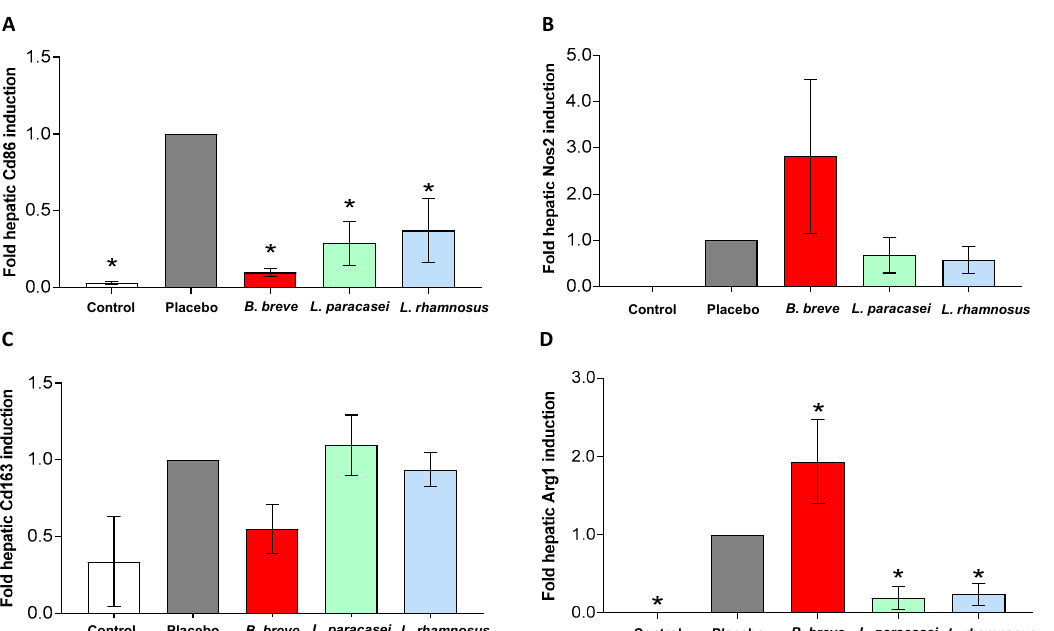
Figure 7. Expression of macrophage genes in liver. M1 macrophage markers: ( A ) Cd86 and ( B ) Nos2. M2 macrophage markers: ( C ) Cd163 and ( D ) Arg1 of rats fed either placebo or B. breve CNCM I-4035, L. paracasei CNCM I-4034 or L. rhamnosus CNCM I-4036 for 30 days. Relative mRNA levels were normalized to the trancript levels of the housekeeping gene Hprt1. Data were calculated as fold change compared with the placebo group. Values are the means ± SEM, n = 3–5 per group. * p < 0.05 vs. placebo. Arg1, Arginase-1; B, Bifidobacterium ; Cd, cluster of differentiation; L, Lactobacillus ; Nos2, Nitric oxide synthase-2.